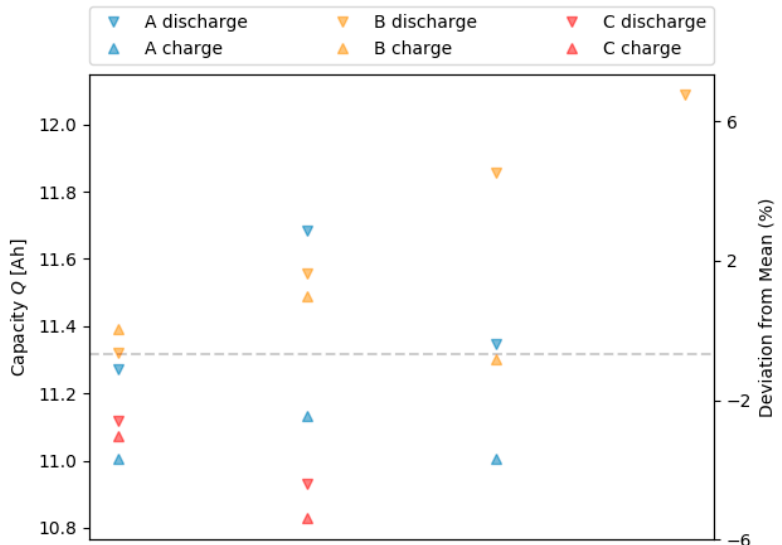
Figure 5. Capacity at charge (up-pointing triangles) and discharge (down-pointing triangles) of three different modules (A, B and C).